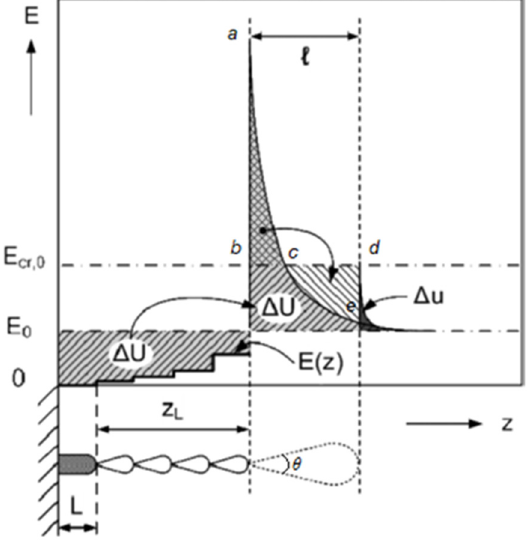
Figure 2. Field redistribution caused by protrusion of length L [32].